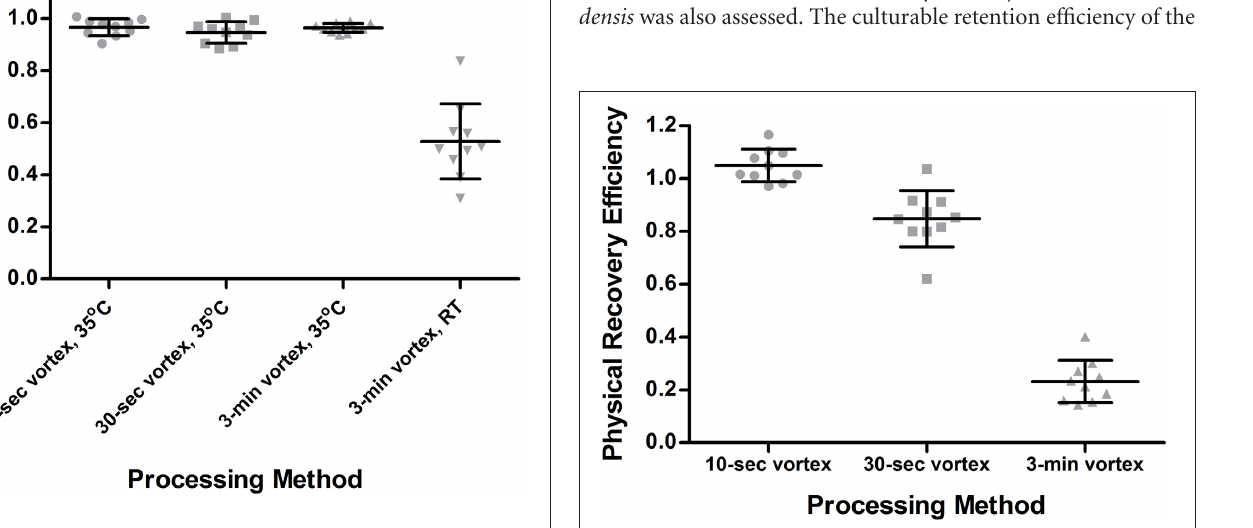
FIGURE 2 | Physical recovery efficiency of 1 µ m fluorescent melamine beads from 22mm stainless steel disks. The physical recovery efficiency of fluorescent beads from stainless steel disks was significantly different for all three processing methods tested ( P < 0 . 0001); lines represent the mean, and ± one standard deviation; n = 10 for each